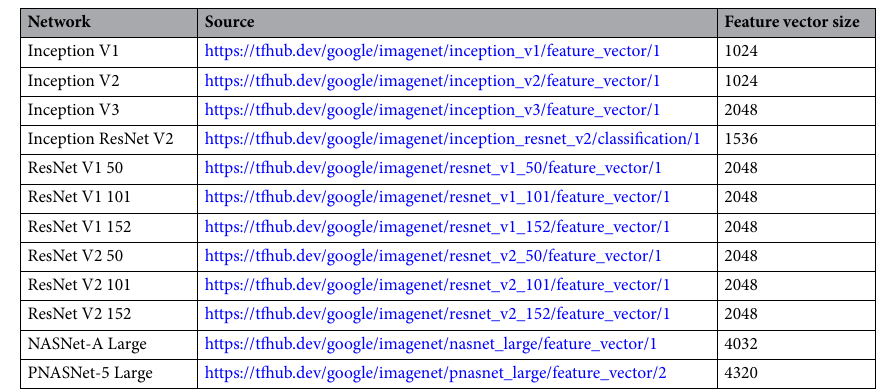
Table 1. Pre-trained networks utilized. Modules were accessed using the respective URL and standard TensorFlow Hub